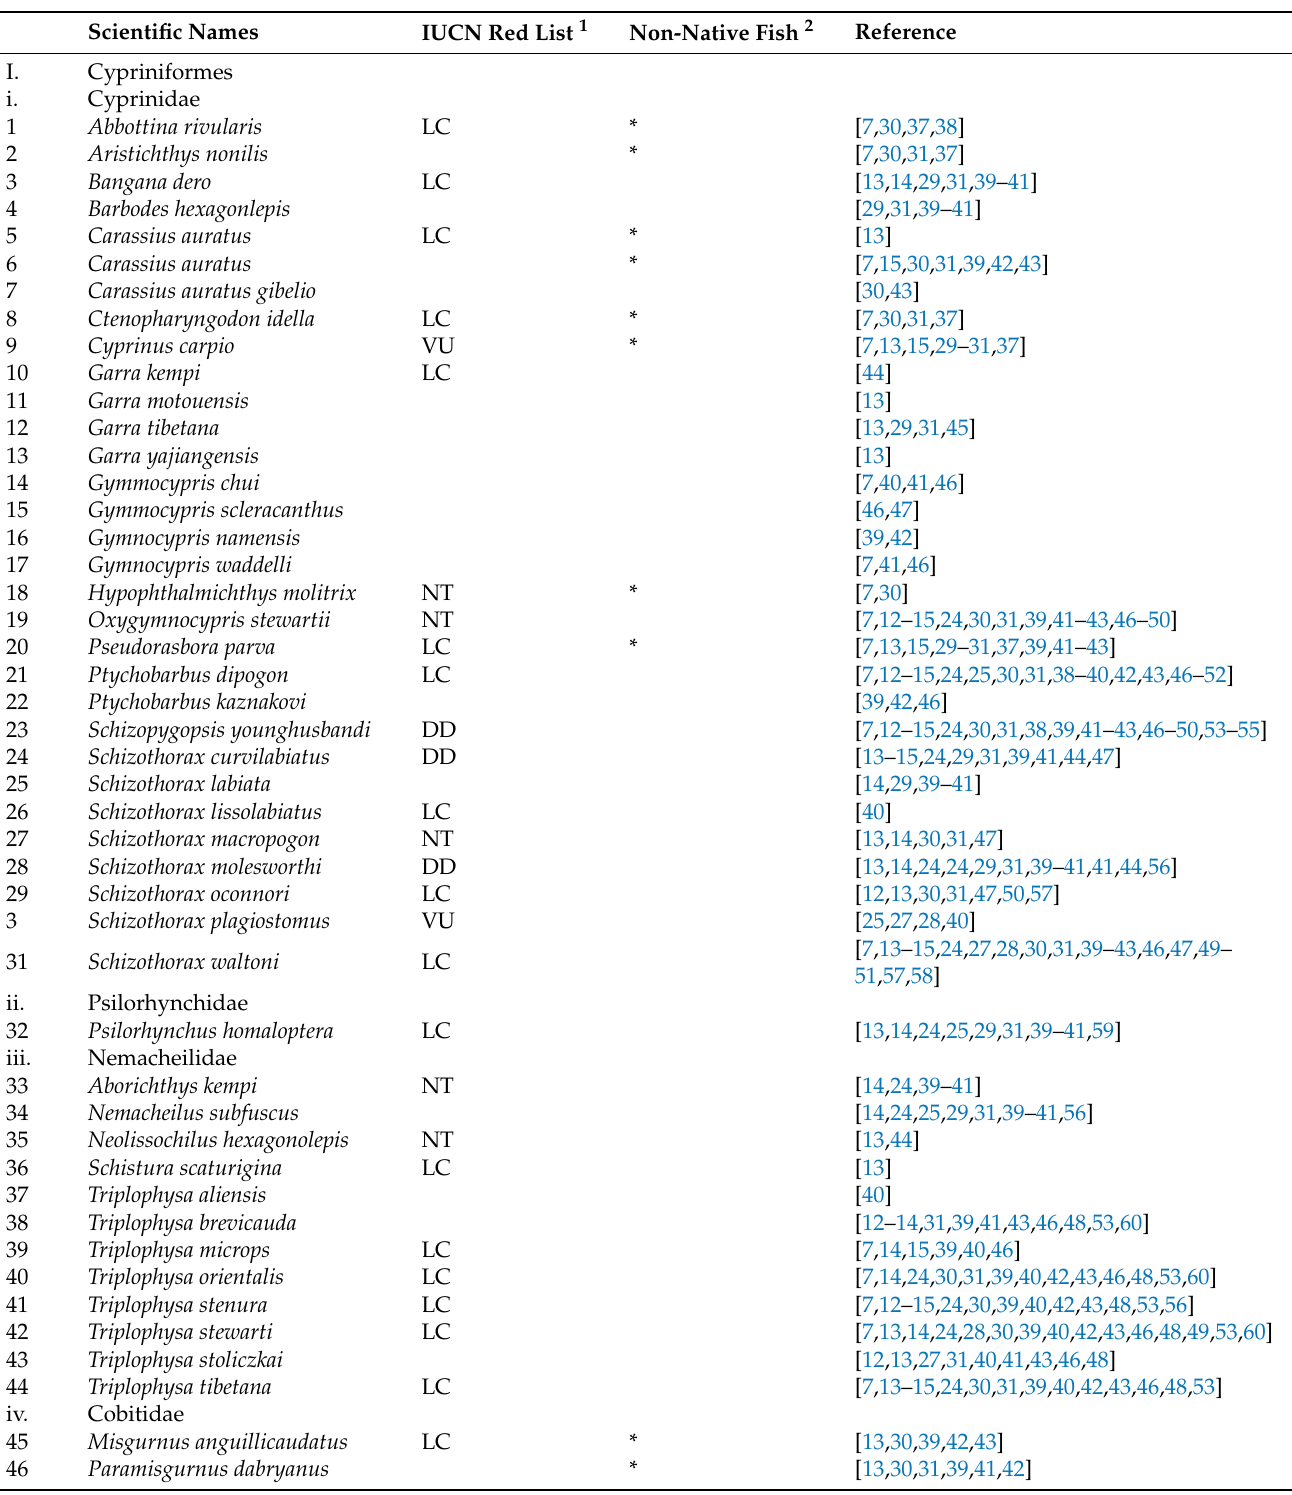
Table 2. List showing fish species composition of the Yarlung Zangbo River: 1 “LC” means “Least Concern”, “VU” means “Vulnerable”, “NT” means “Near Threatened”, “DD” means “Data Deficient”; 2 Reference: “Fish on the Tibetan Plateau” [26]. The presence of an asterisk indicates that the species is a non-native fish, and its absence indicates that the species is a native